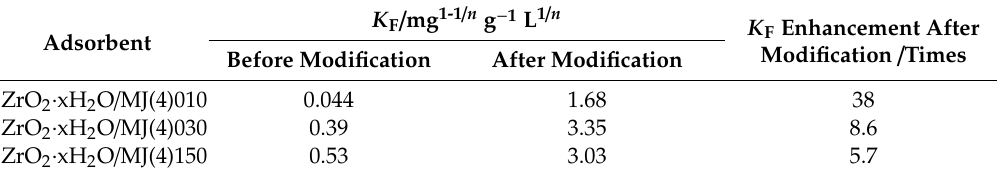
Table 3. F − adsorption capacity K F of prepared adsorbents and unmodified mesoporous carbons.